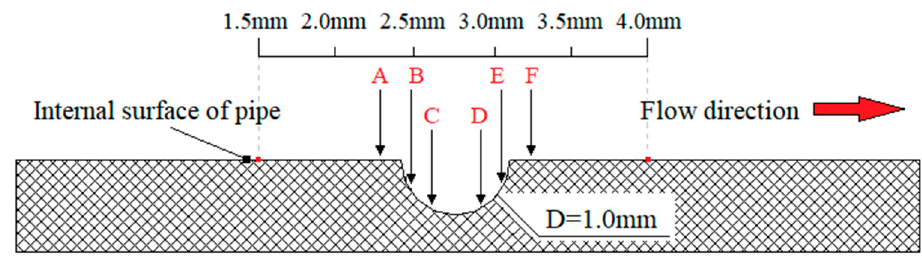
Figure 11. Pipeline corrosion defect model.